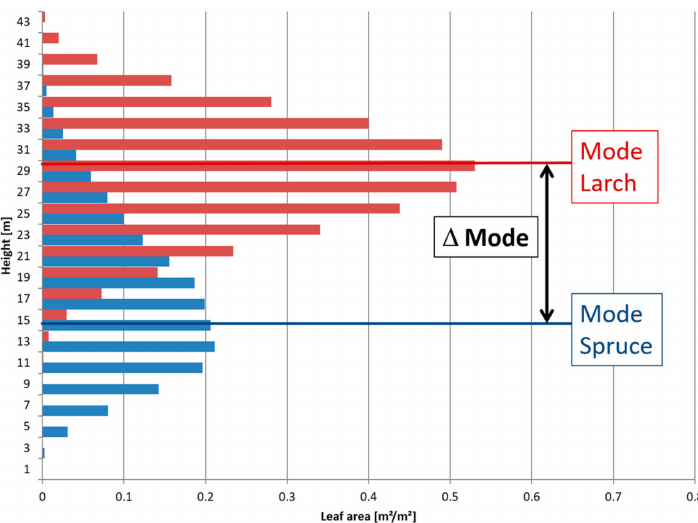
Figure 8. Leaf area distribution by species and height within an exemplary stand (Plot ID =